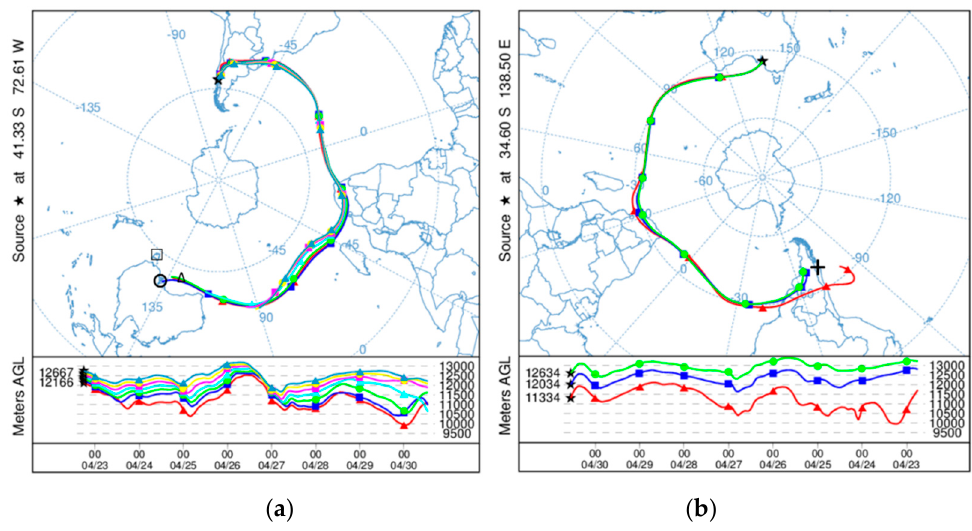
Figure 3. Hybrid Single Particle Lagrangian Integrated Trajectory Model (HYSPLIT) trajectory analysis using European Centre for Medium-Range Weather Forecasts Interim Reanalysis (ERA-Interim) 0.75° reanalysis. ( a ) Forward trajectories started at the geographical location of Calbuco at 22 April 2015 18:11 Universal Time (UT), the time of the first eruption, for starting heights above mean sea level (MSL) of 12.8 km to 13.4 km at 100 m intervals. The duration is 187 h and ends at approximately the time of the Buckland Park lidar measurement on 30 April. The source location is marked by a black filled star. Colored filled markers are placed along each trajectory at 00:00 UT each day. An open circle and open square mark the location of the Buckland Park and Kingston lidars, respectively. The center of the open triangle is at the approximate geographical location of the enhanced backscatter marked with an arrow in Figure 2a. ( b ) Backward trajectories started at Buckland Park at 30 April 2015 13:00 UT at heights above MSL of 11.45, 12.15 and 12.75 km (corresponding to layers of enhanced backscatter in Figure 1b). The duration of the run is 187 h and ends at 22 April 2015 18:00 UT. The location of Calbuco is marked by ‘+’. The lower panels show time series of the height of each trajectory above ground level (AGL).